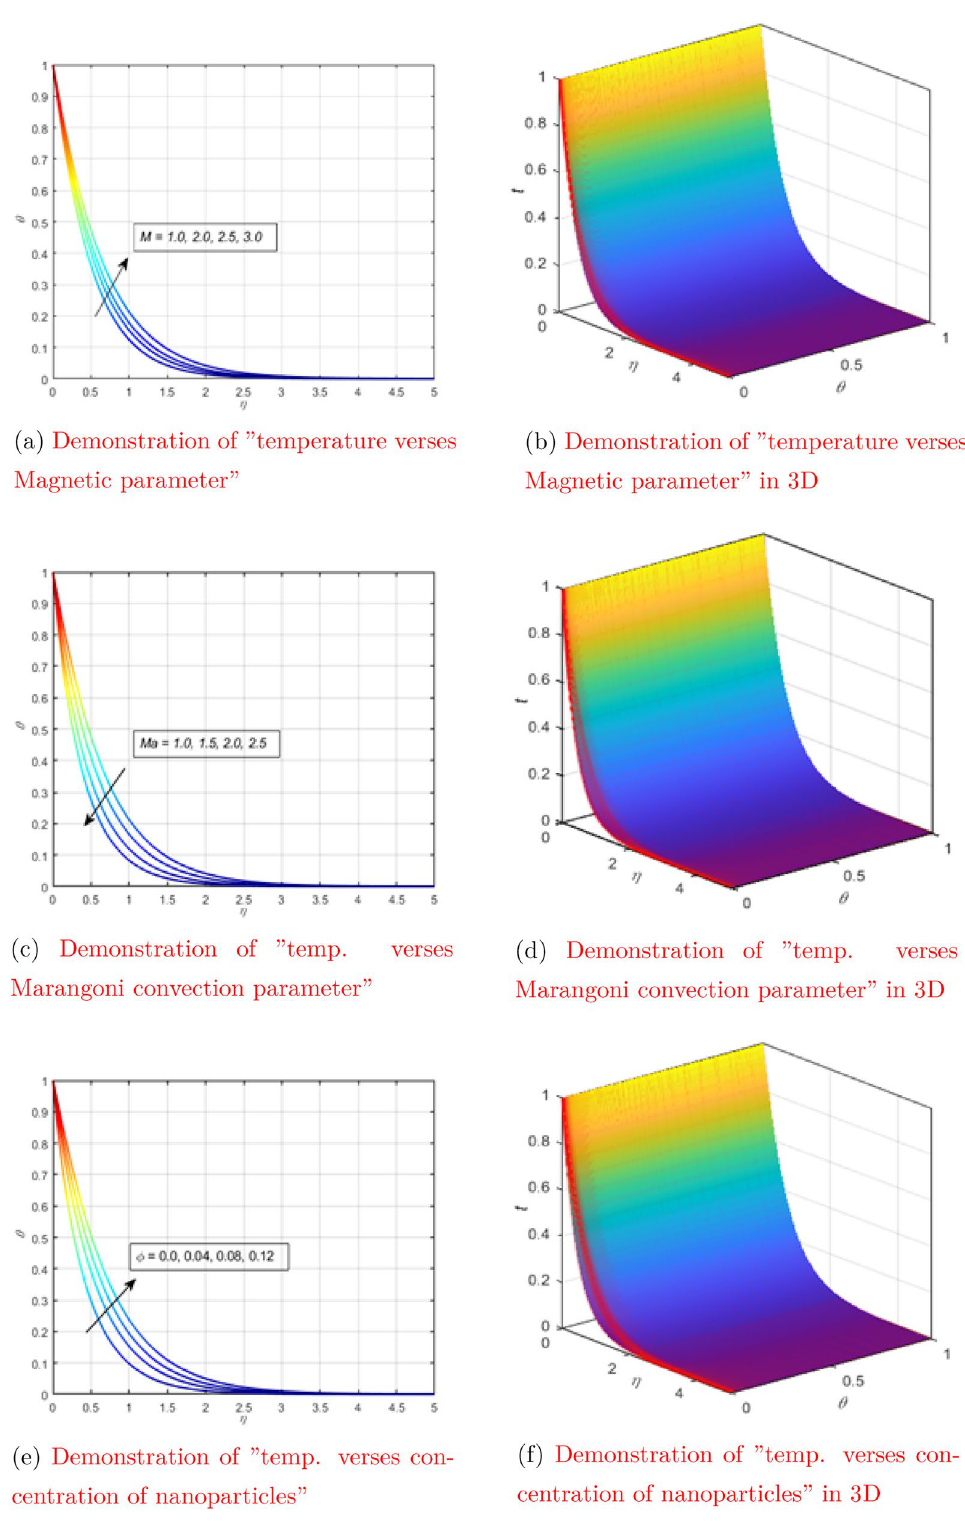
Figure 4. Demonstration of “temperature verses different physical parameters” (see Appendix